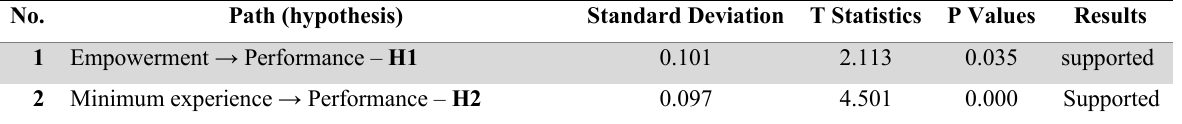
Summary of hypothesis testing